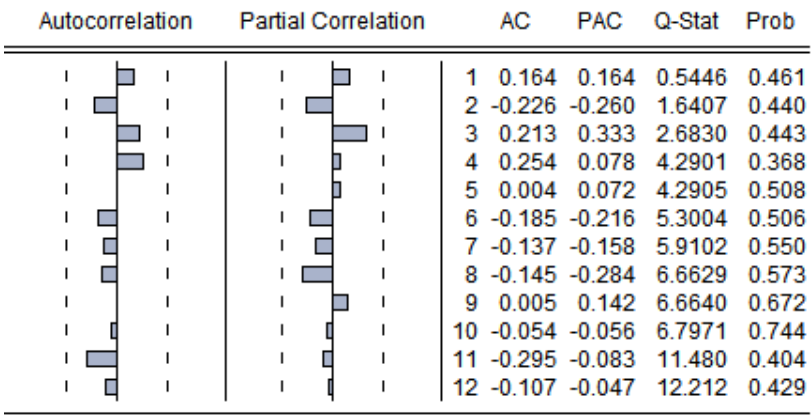
Table 6. Parameters of the goodness of fit for the ARIMA (11,1,2) Model.